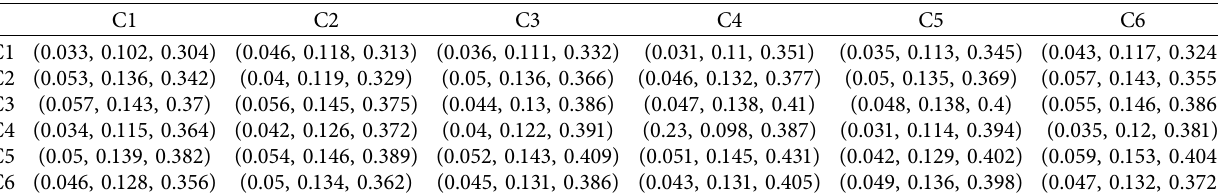
Table 6: Total-influential matrix